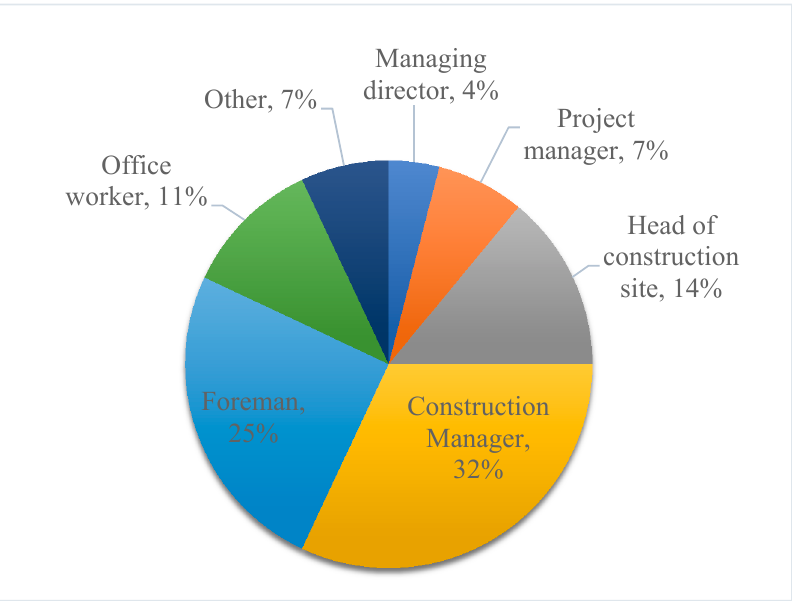
Figure 7. Working departments of the respondents.